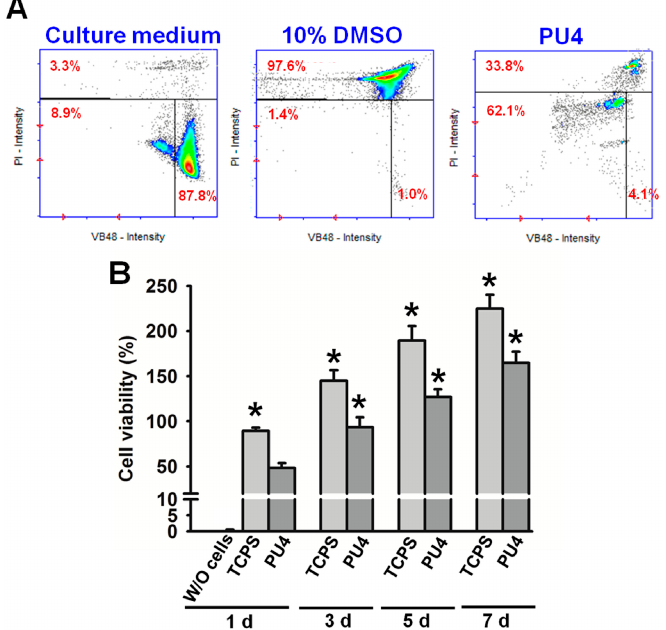
Figure 6. ( A ) The cell vitality (%) of hMSCs in PU4 hydrogel and in the culture medium with or without 10 wt % of DMSO; ( B ) the cell viability (%) of hMSCs in PU4 hydrogel and in the blank well (tissue culture polystyrene TCPS) at the first, third, fifth and seventh day of culture. The values were normalized to those of cells before culture (100% viability). Significance ( p < 0.05): * higher than the PU4 group at 1 day. “W/O” indicates the medium without cells.